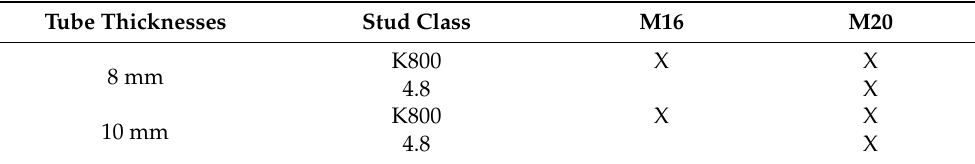
Table 1. Combinations of tube thicknesses, stud classes (K800 and 4.8), and stud diameters (16 mm and 20 mm)